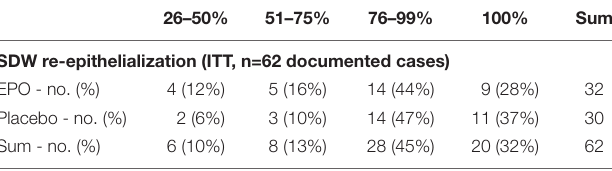
TABLE 6 | Analysis of secondary outcome: SDW Re-epithelialization.